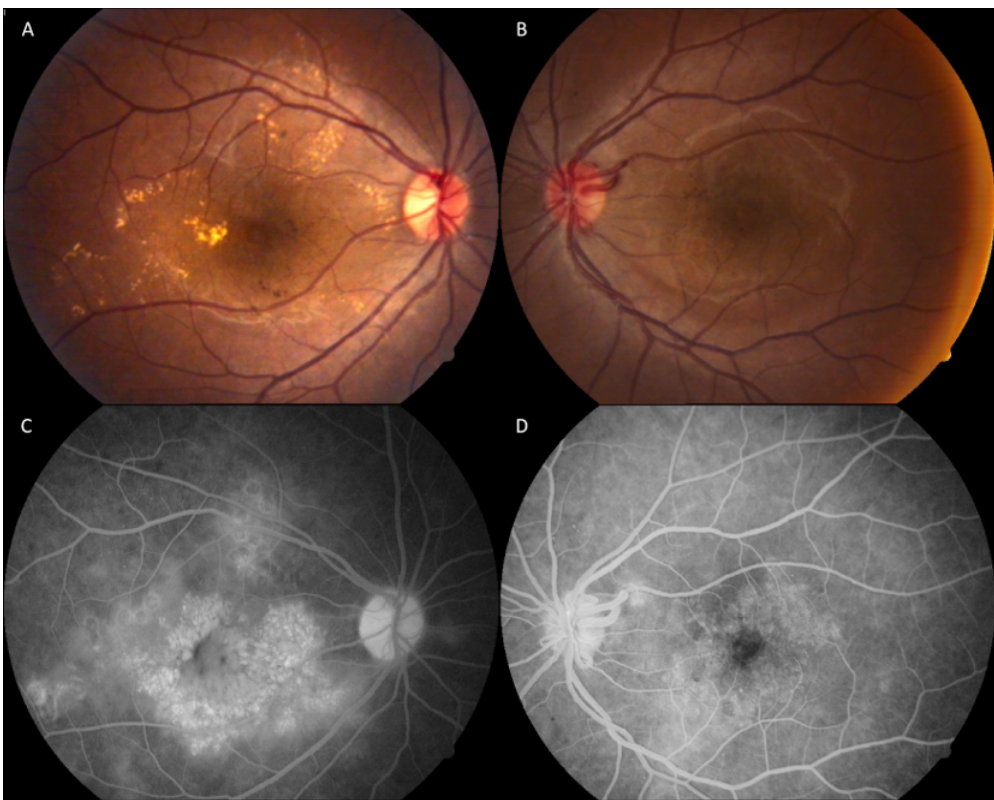
Figure 1: Color fundus photography (initial manifestation): radiation maculopathy with enlarged arterial calibration, intraretinal hemorrhages, exudates, microaneurisms, and diffuse macular edema (A, B) Fundus fluorescein angiography (late venous phase): bilateral enlarged and clear-cut foveal avascular zone with perifoveal teleangiectasia and diffuse macular edema (C, D)